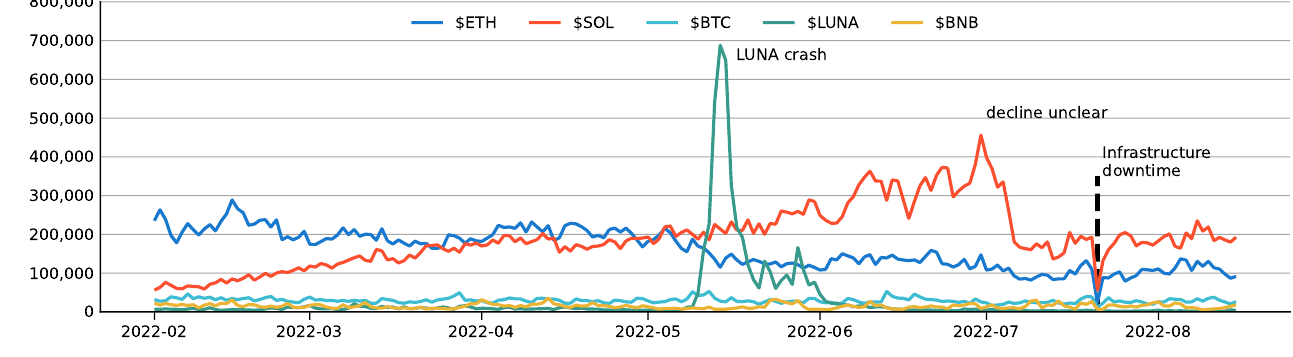
Figure 10. Recorded symbols per day (evaluation phase of Use Case